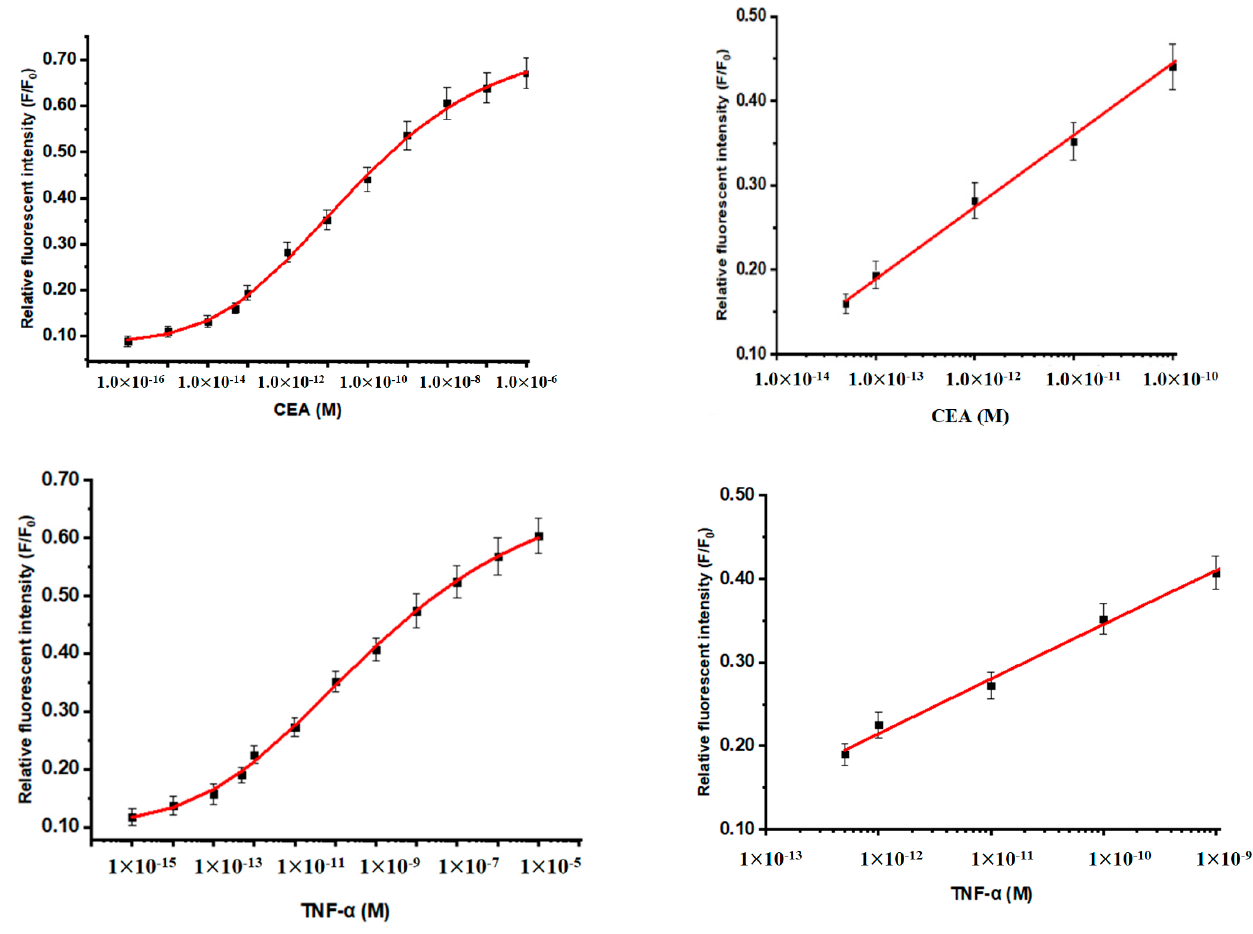
Figure 4. Reference plots of CEA and TNF- α for the magnetic fluorescence-linked immunoassay. Table 1. Comparison of detection limit and linear range for CEA and TNF- α .